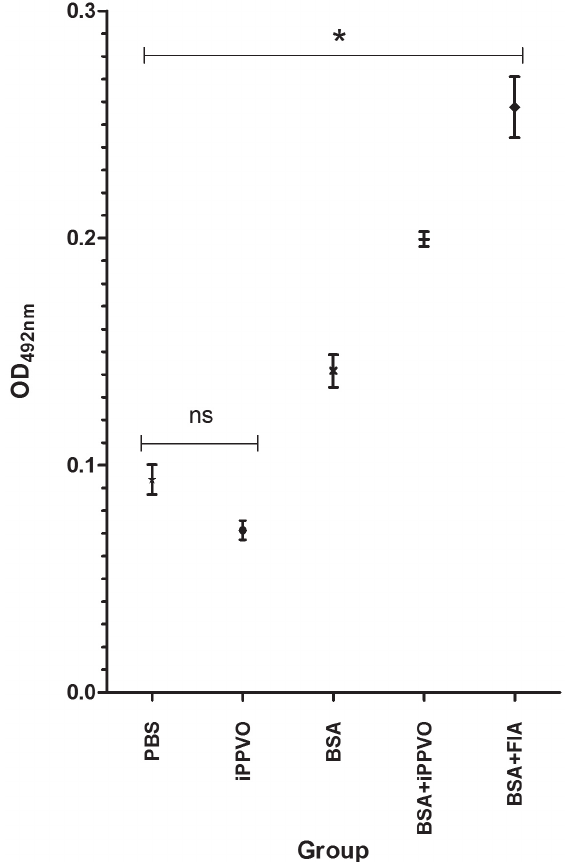
figure 2 - Anti-BSA antibody production in silver catfish. Fish were inoculated with phosphate buffered saline (PBS), iPPVO, BSA, BSA + iPPVO or BSA + FIA. Serum samples were collected 35 days p.i. and anti-BSA antibody titers measured by ELISA. Data represent the means ± S.E.M. (n = 15) and were compared using two-way ANOVA and Bonferroni post- test. Significant differences (p < 0.05) amongst groups are indicated by